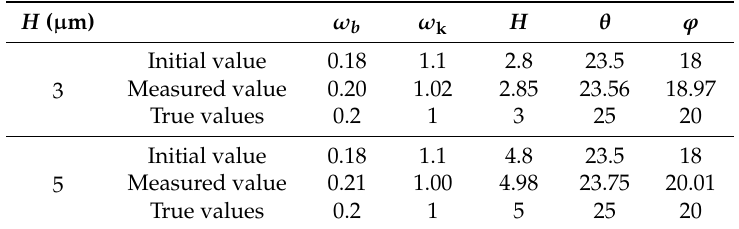
Figure 3. Measured Mueller matrix spectra (blue) and fitted Mueller matrix spectra (red) for the volume gratings whose dielectric constant is a periodic linear distribution, with thicknesses of ( a ) 3 µ m and ( b ) 5 µ m, respectively. Table 2. Simulation results of case 2.